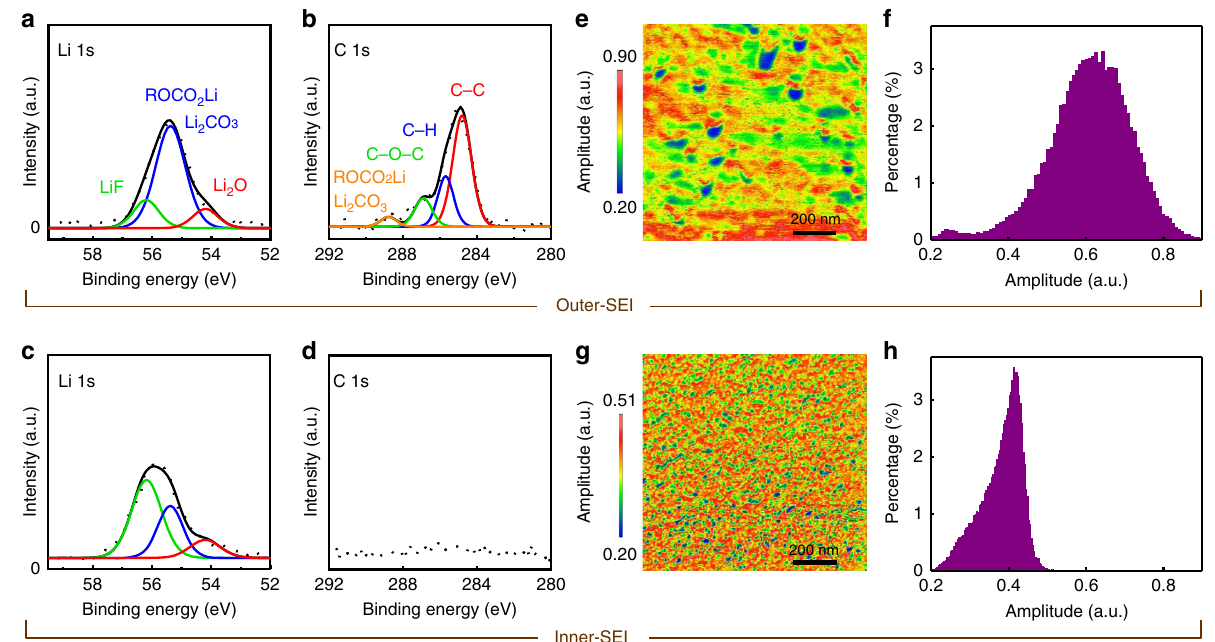
Fig. 6 Composition and lithium-ion mobility of the dual-layer SEI. Li 1s and C 1s sputter-etched XPS spectra of the Si electrode after the 6th cycle. The spectra in a and b were obtained without sputter-etching the SEI surface and represent the chemical information of the outer-SEI layer. The spectra in c and d were recorded after about 10s of sputter-etching and represent the chemical information of the inner-SEI layer. ESM amplitude map ( e ) and corresponding histogram ( f ) of the Si electrode after the 6th cycle. ESM amplitude map ( g ) and corresponding histogram ( h ) of another Si electrode, after being scanned to + 5 mV during its fi rst CV cycle at a scan rate of 7 mVs − 1 . The center contact resonance frequency of the tip-sample system was 290kHz for the two ESM